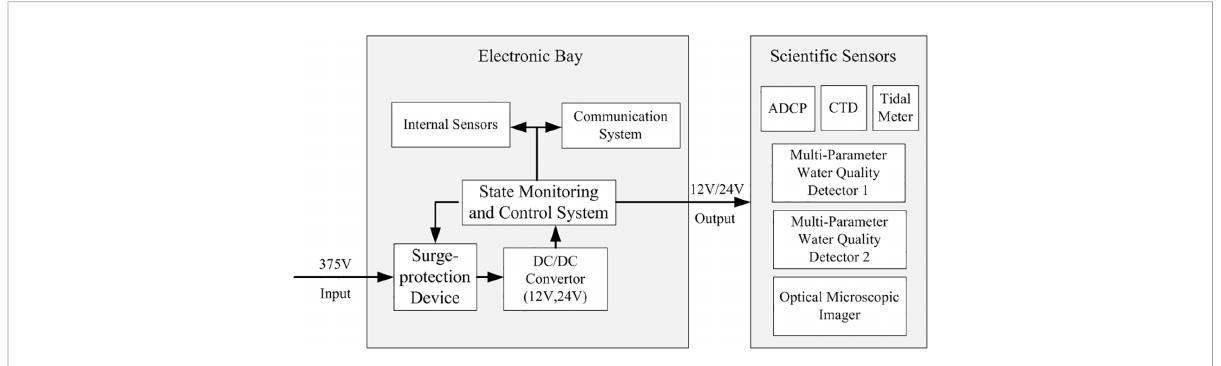
FIGURE 2 Diagram of power supply system of electronic